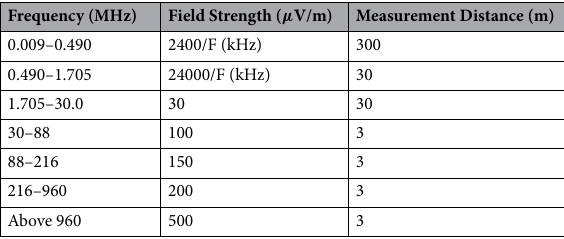
Table 1. FCC field limit regulations for unintentional radiators 17 .